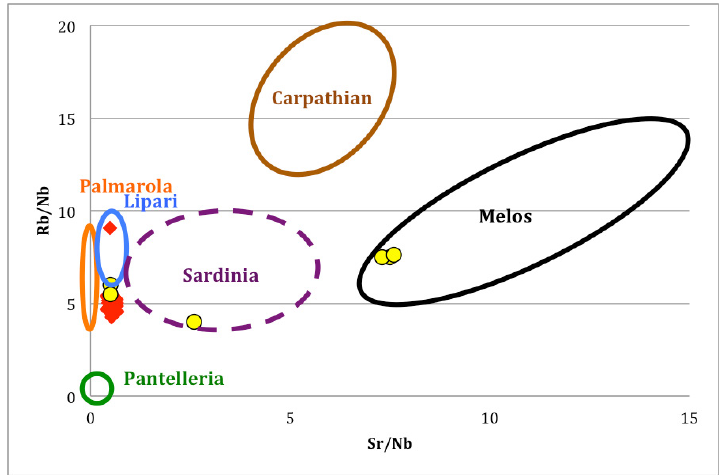
Figure 2e . Rb/Nb vs Sr/Nb from Stromboli and two published data set: Tykot (2017, compositional ranges from fig. 4a) and Acquafredda et al. 2018 (yellow circles). There is a good agreement between the Stromboli group (red diamonds) and the Acquafredda Lipari’s